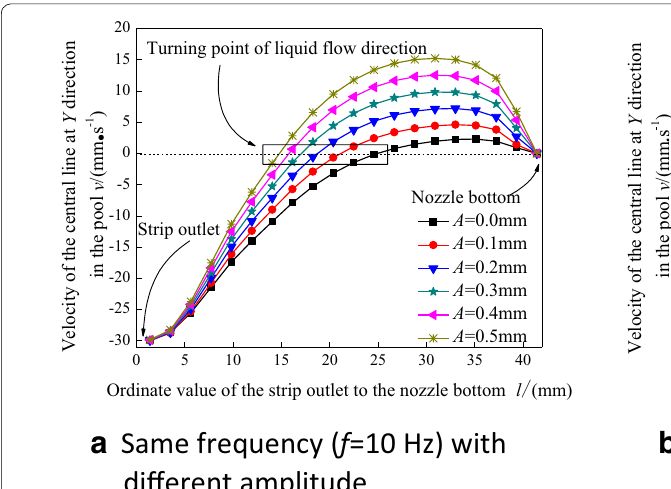
roller. The inflection point of velocity direction chang- frequency ( f 10 Hz) and different amplitude, (b) with = ing move to the exit of the strip (Line 1) under the offset constant amplitude ( A 0.5 mm) and different fre- = by the right oscillating roller with the strip casting veloc- quency. Negative velocity of the center line corresponds ity. The greater the amplitude/frequency, the greater the to the same direction with the strip casting, while posi- instantaneous velocity of the casting roller up, which tive velocity of the central line corresponds to the oppo- offset with the exit velocity, leading to the Y direction site direction. The velocity point of zero is the transition velocity distribution below the inflection point. Above limit of the fluid velocity direction change. When there the inflection point, the metal liquid flow is relatively is no oscillation, the stream line is shown in Figure 3(a), simple, the greater the amplitude/frequency, the greater the metal liquid below the inflection point is affected by the influence of the oscillation on the metal liquid flow. the strip of the exit velocity, the flow has the same direc- Moreover, the velocity increases and then decreases tion with the strip roll casting and the velocity increases. under the influence of no slip at the bottom of the nozzle. Above the inflection point, there are opposite and sym- Figure 4 shows the velocity of the center line in the Y metric vortices, and the velocity of the center line is offset direction at the down balance position. When the oscil- by the vortex. Therefore, the flow is opposite to the cast- lating roller is at the down balance position, as shown ing velocity. When the right roller oscillates, as shown in in Figure 3(c), the casting roller movement direction is Figure 3(b), double vortices on both sides of the nozzle the same with the direction of the casting. The velocity evaluate to a single vortex on the left side of the nozzle. of the center line in the Y direction is determined by the The single left vortex is forced to gradually move closer casting and the oscillating roller velocity. Thus, when to the left casting roller. The Y direction velocity of the the frequency/amplitude is constant, the greater the center line is mainly controlled by the right oscillating